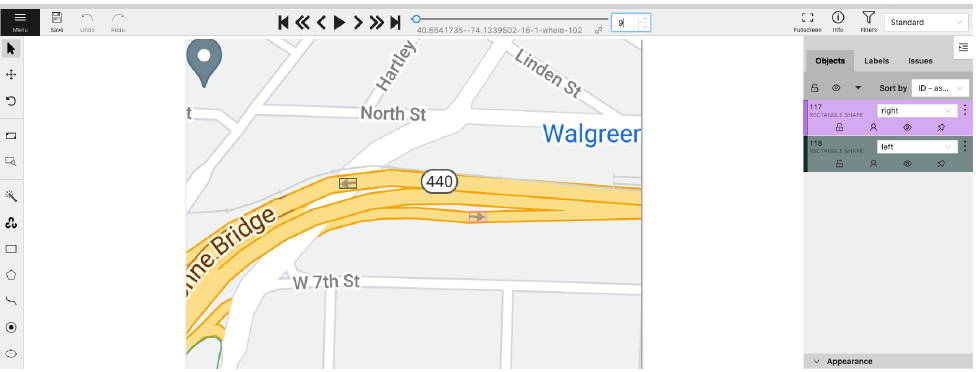
Figure 6. Data labeling using CVAT online